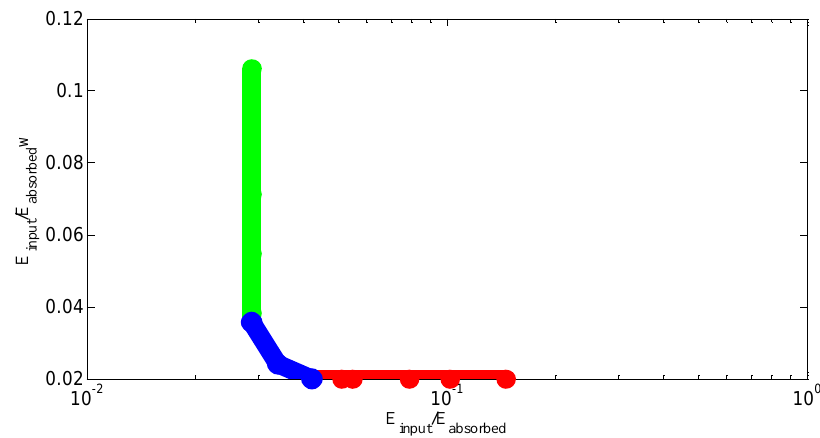
Fig. 11. Pressure impulse curve for SDOF system subjected to blast load on roof wall.